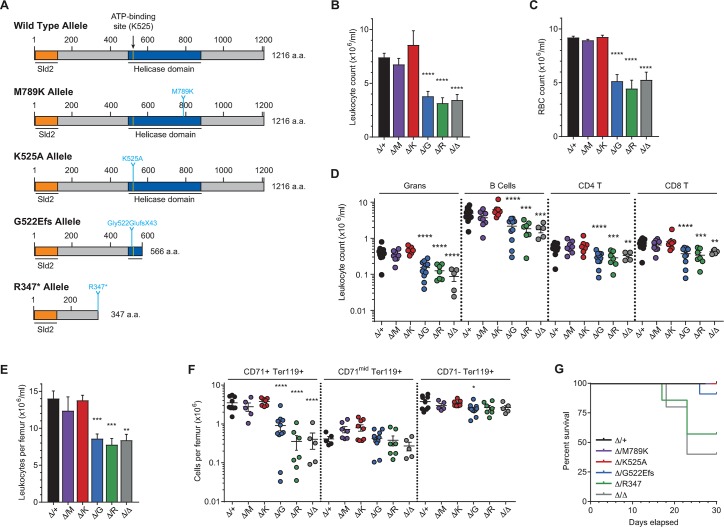
Truncating mutations, but not helicase inactivation, result in deleterious effects.(A) Schematic representation of the R26-CreER Recql4fl/PM murine alleles used in this study. (B) Leukocyte counts in PB. (C) Red Blood Cell counts in PB. (D) Absolute numbers of leukocyte subsets in PB. (E) Leukocyte counts in BM. (F) Erythroid fractions based on CD71/Ter119 staining per femur. (G) Kaplan-Meier survival plots of the indicated genotypes in days on Tamoxifen food. All data are from day of sacrifice and expressed as mean ± SEM, Student’s t test. *P<0.05; **P<0.01; ***P<0.001; ****P<0.0001; n≥6 per genotype (B-F). Experiments were independently executed on separate cohorts, with results pooled for presentation. M = M789K; K = K525A; G = G522Efs; R = R347*.